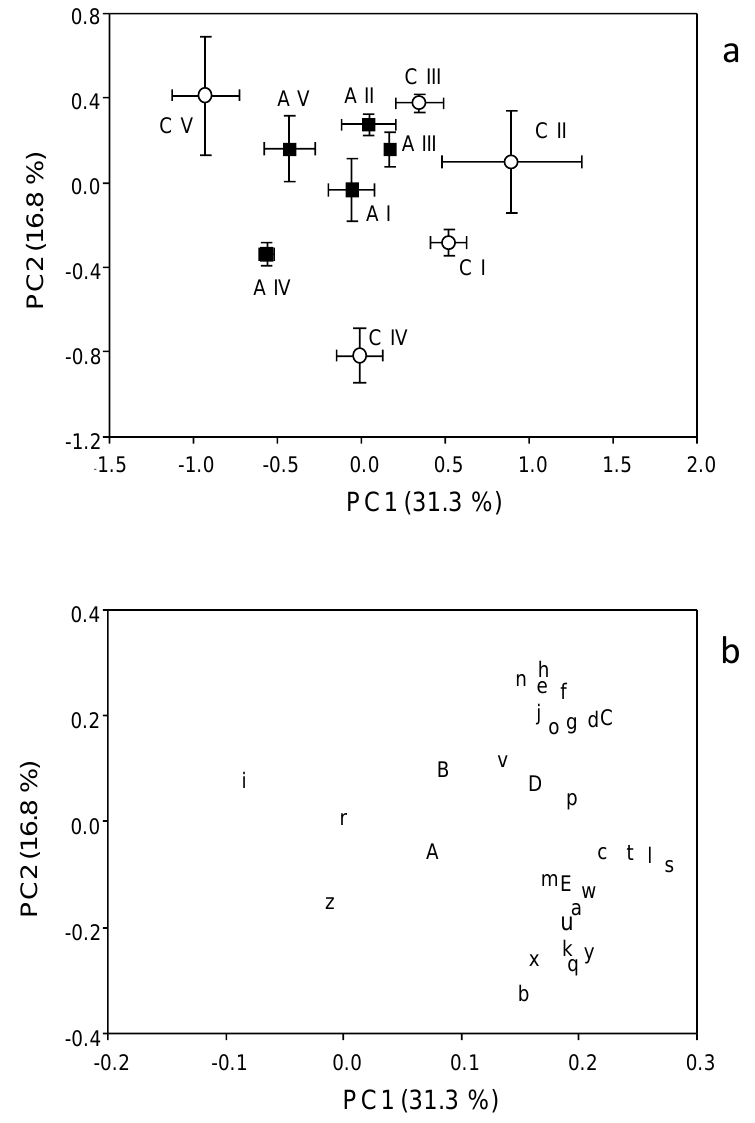
Figure 7. Scores ( a ) and loading ( b ) plots of the principal component analysis applied to the Biolog of the chestnut (C) and agricultural (A) soils. The letters in the loading plot indicate the 31 substrates as indicated in Table